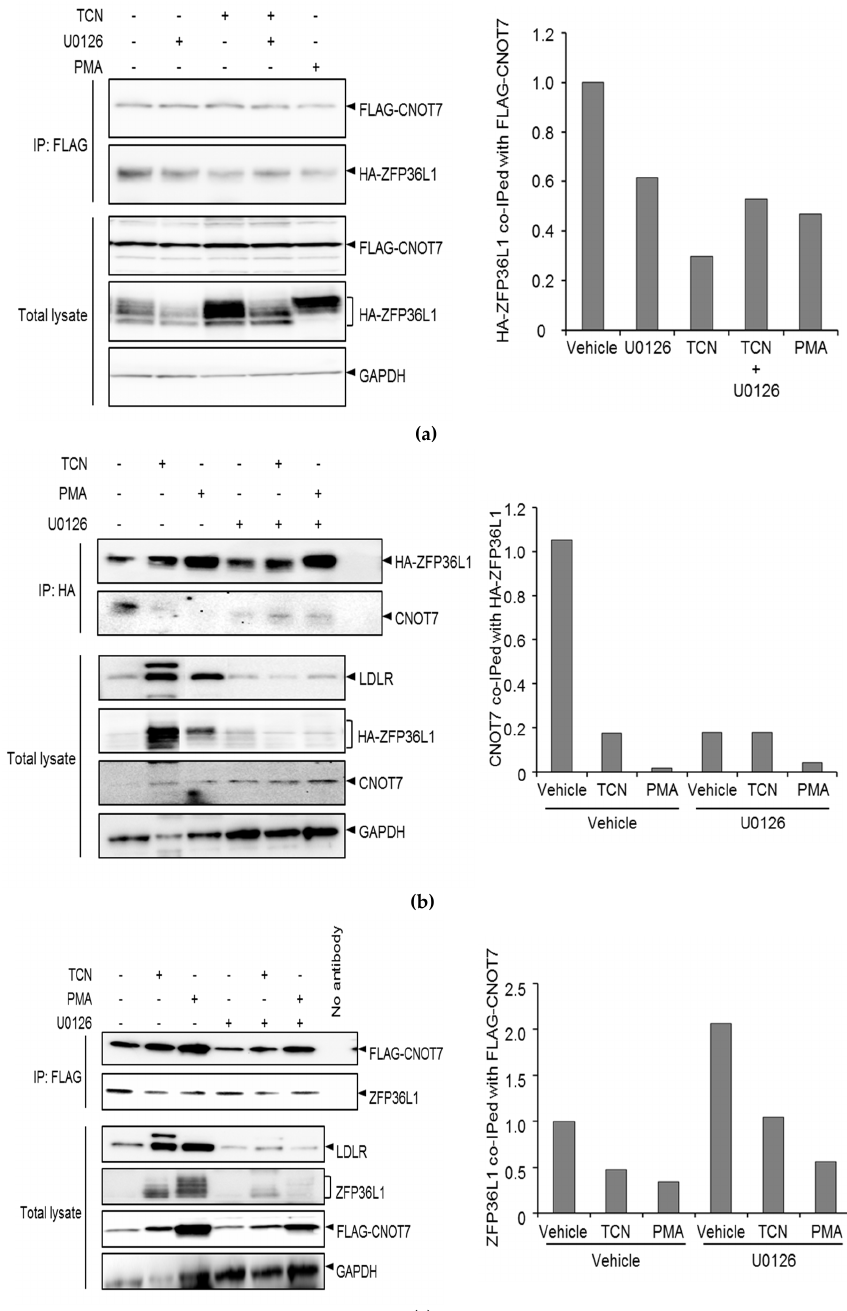
Figure 5. TCN inhibits association of ZFP36L1 with CNOT7. ( a ) HepG2 cells were co-transfected with FLAG-CNOT7 and HA-ZFP36L1. ( b ) HepG2 cells were transfected with HA-ZFP36L1. ( c ) HepG2 cells were transfected with FLAG-CNOT7. ( a – c ). One day post transfection cells were treated with or without U0126 for one hour before exposure to TCN or PMA for four hours. Lysate were subjected to immunoprecipitation with the indicated antibodies and retrieved immunocomplexes and total lysate were subjected to immunoblotting with the indicated antibodies. IP: immunoprecipitation.